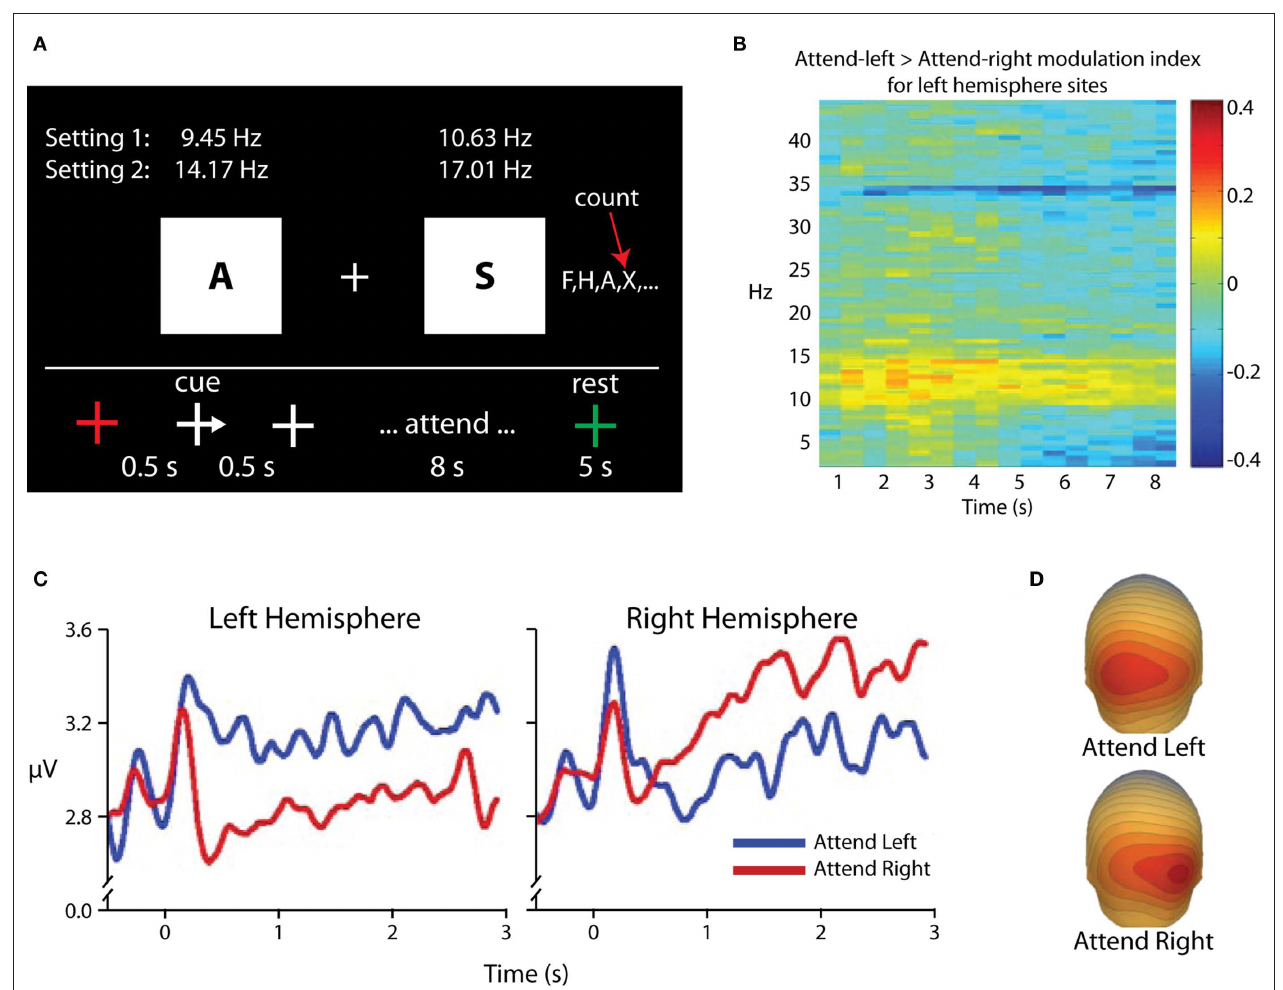
hemisphere parieto-occipital electrodes. Modulation is localized to the alpha band with additional modulations seen at stimulation frequencies and harmonics. (C) TSE waveforms time-locked to cue-onset (0 ms), averaged over three parieto- occipital electrodes from each hemiscalp. A marked increase relative to pre-cue baseline can be seen over each hemisphere when ignoring the contralateral hemifield. (D) Scalp topography of alpha-band power for attention deployments toward the left (top) and right (bottom) stimuli. The focus of increased alpha can be seen over parieto-occipital scalp contralateral to the